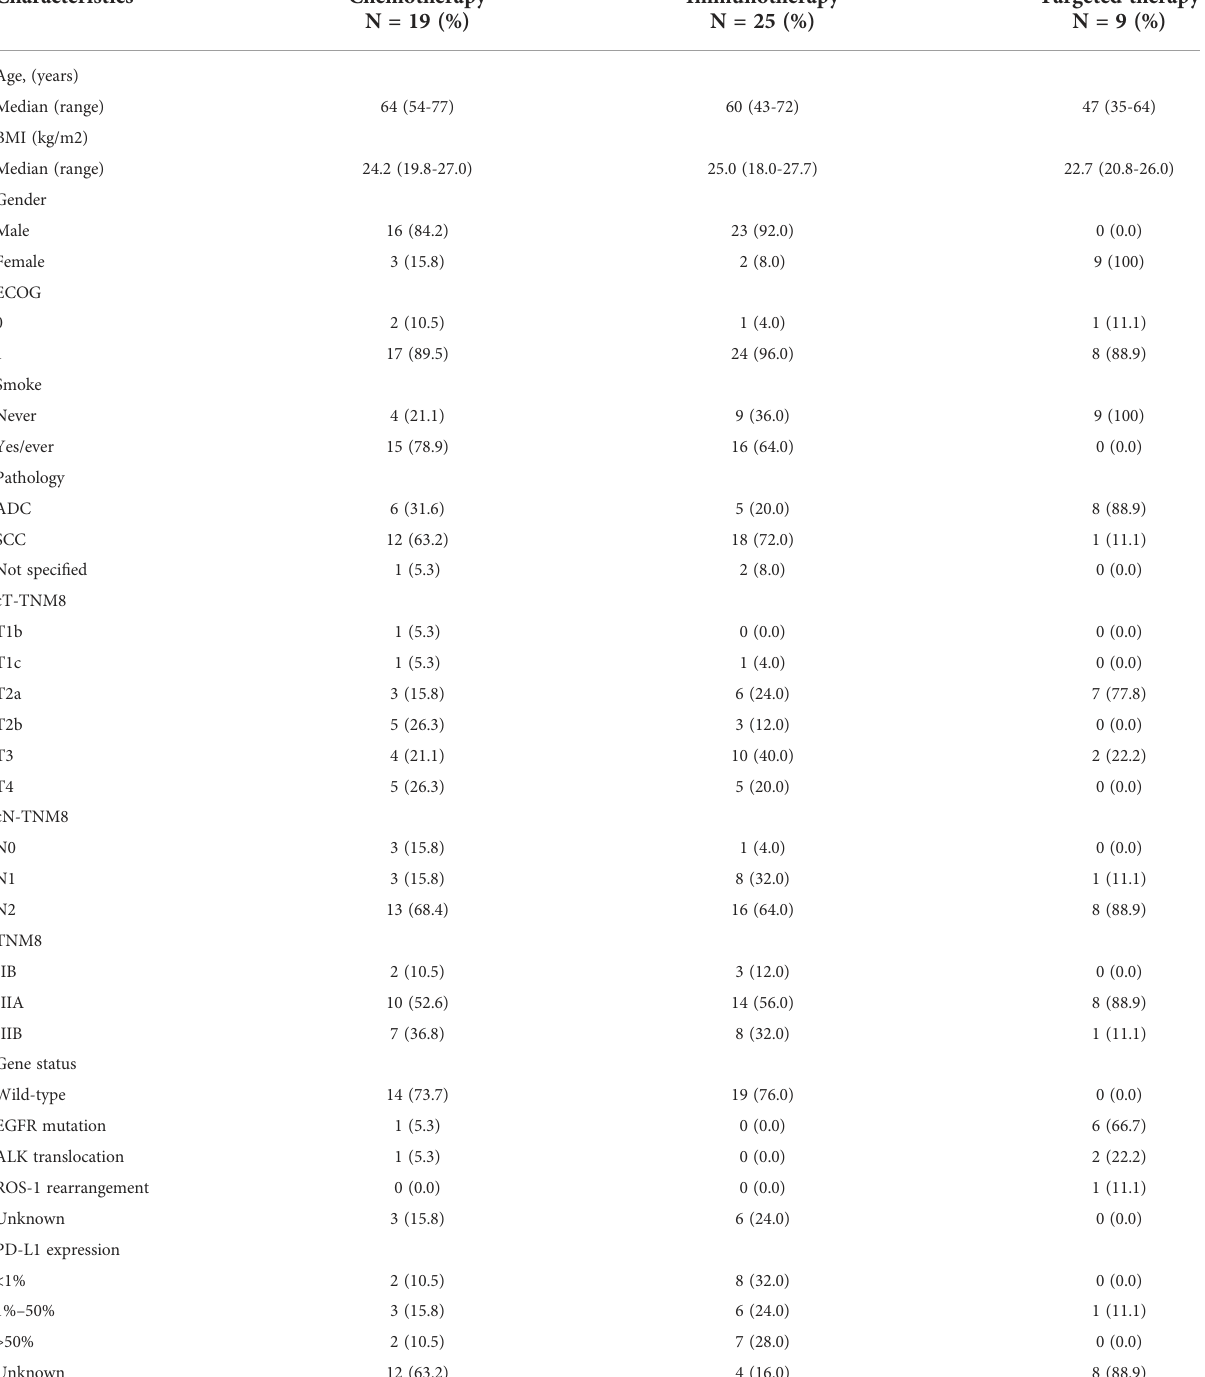
TABLE 1 Baseline characteristics of all patients (N =